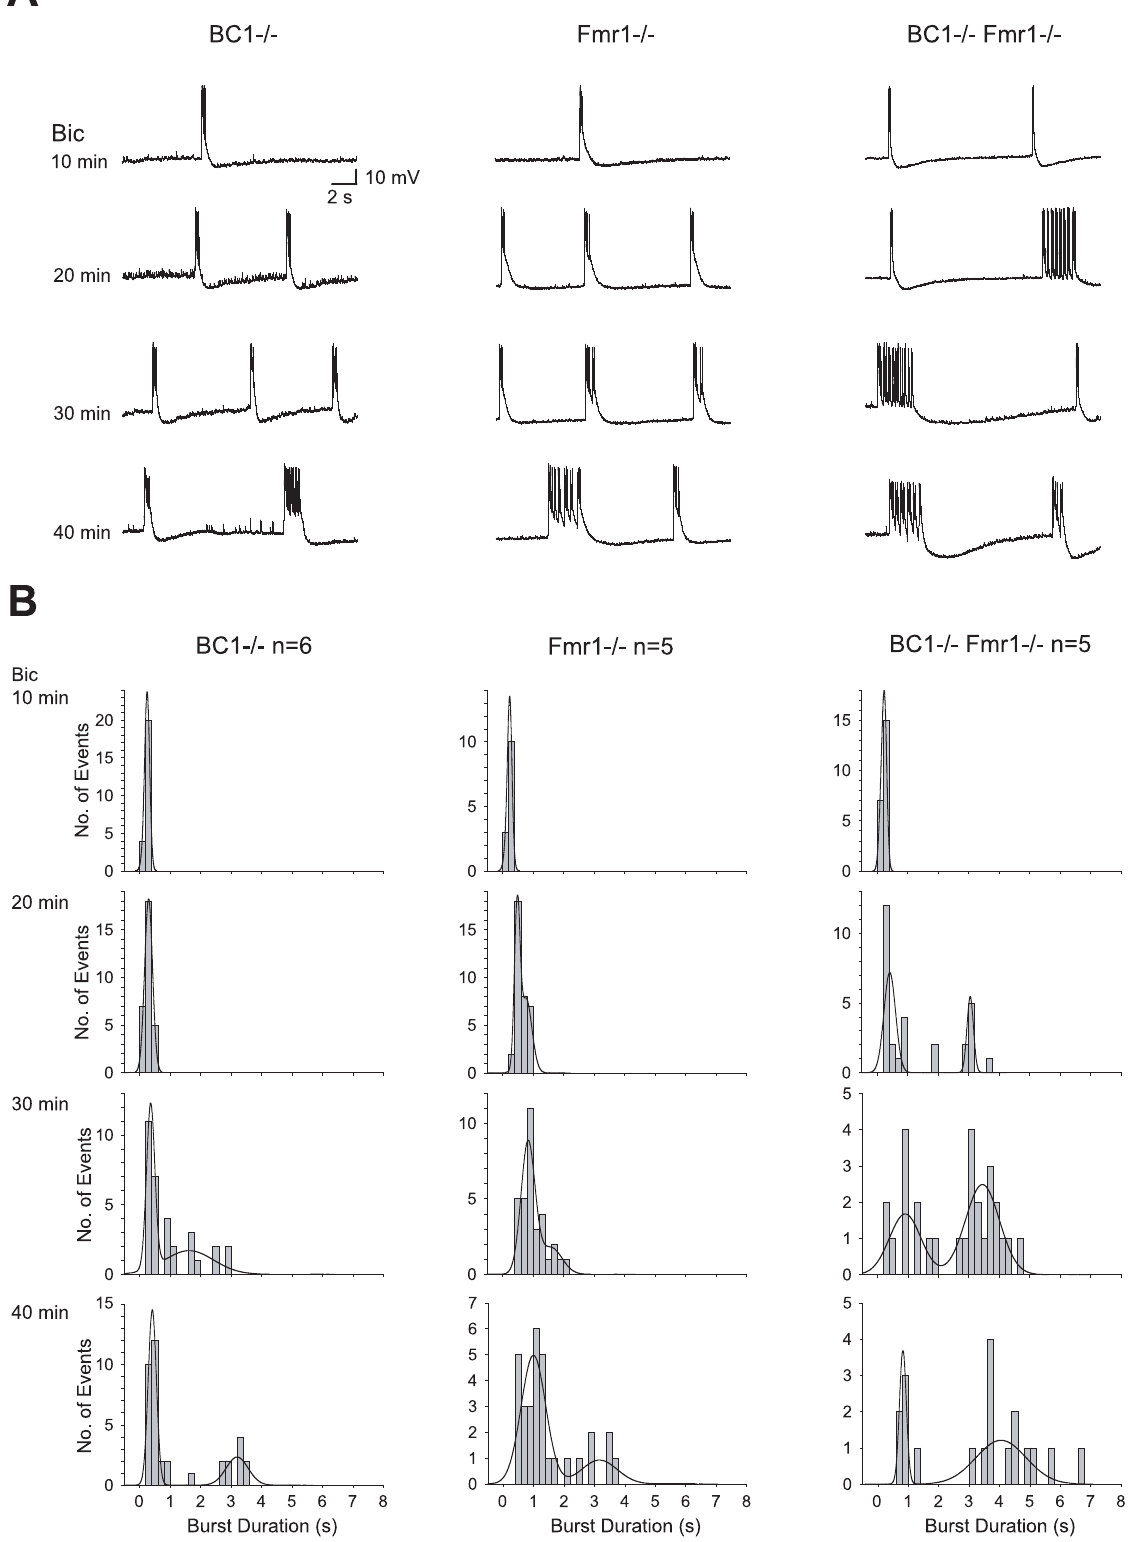
Figure 1. Concurrent absence of BC1 RNA and FMRP gives rise to exacerbated synaptic hyperexcitability of CA3 pyramidal cells. ( A ) Prolonged epileptiform discharges induced by bicuculline (Bic) in hippocampal slices occurred earlier (20 min) in BC1 2 / 2 Fmr1 2 / 2 slice preparations (right column) than in BC1 2 / 2 (left column) or Fmr1 2 / 2 (middle column) preparations. ( B ) Summary frequency histograms from each